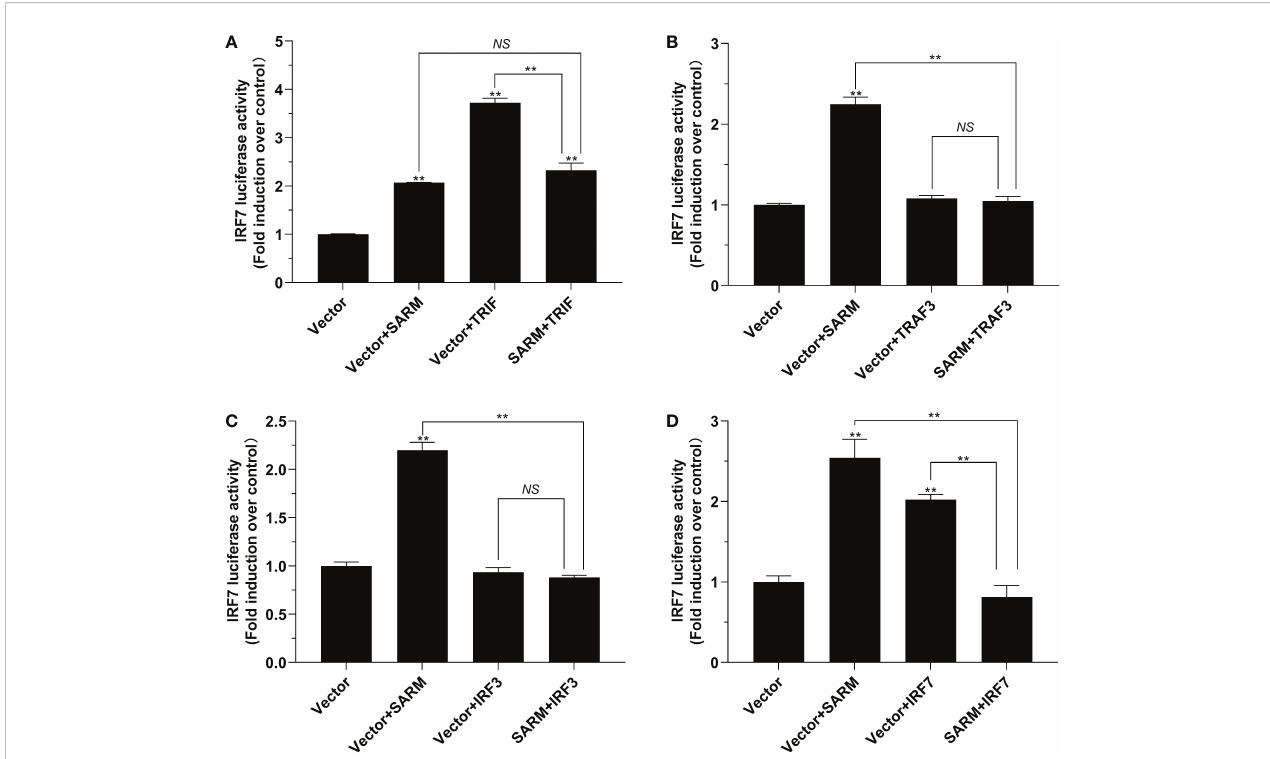
FIGURE 8 The role of Lc- SARM in the regulation of IRF7 signaling. The associations of Lc- SARM with Lc- TRIF (A) , Lc- TRAF3 (B) , Lc- IRF3 (C) and Lc- IRF7 (D) in the IRF7 promoter activation were analyzed by luciferase reporter assays. HEK 293T cells seeded in 24-well plates were co-transfected with 100 ng of pGL4- IRF7-pro and 10 ng pRL-TK together with 100 ng of pcDNA3.1-SARM, pcDNA3.1-TRIF, pcDNA3.1-TRAF3, pcDNA3.1-IRF3, and pcDNA3.1-IRF7 alone or in a combination of two as described above. The cells were harvested at 24 hpt and used for the measurement of luciferase activities. All data are presented as mean of three independent experiments, with bars representing the SE. * P < 0.05; ** P < 0.01; NS, not signi fi